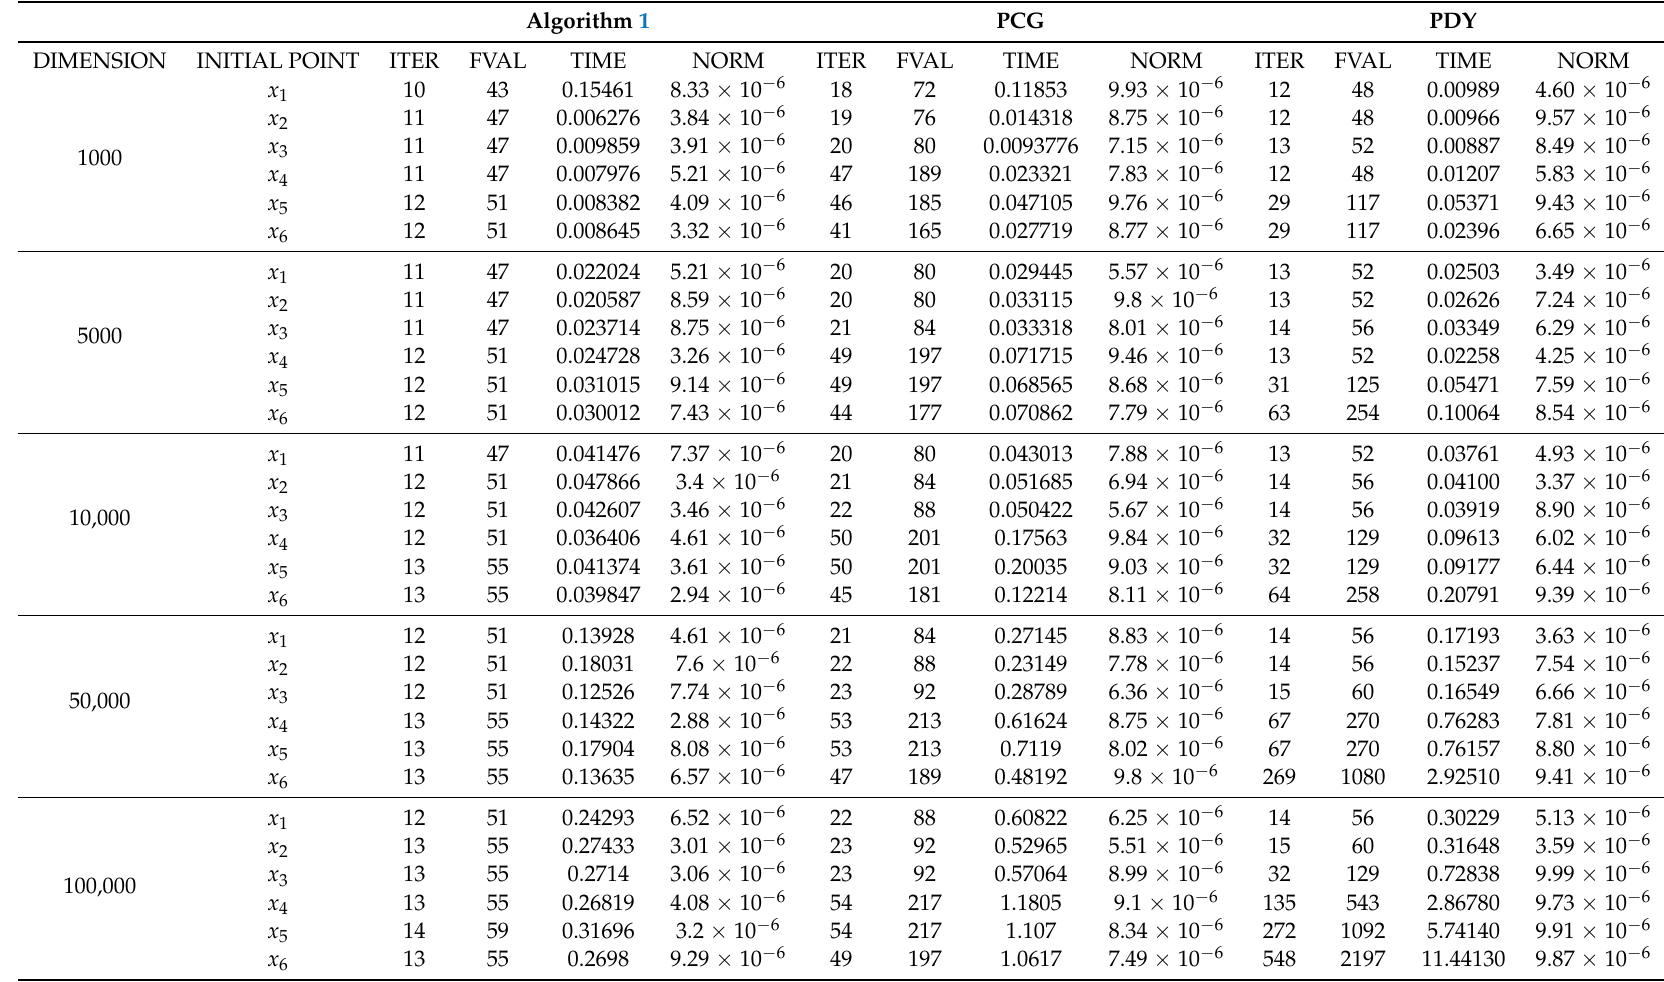
Table 4. Numerical Results for Algorithm 1 (DCG) , PCG and PDY for Problem 4 with given initial points and